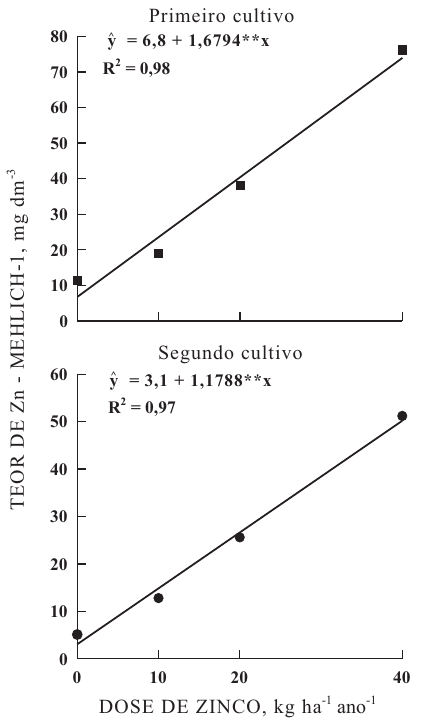
Figura 2. Teor de Zn no solo extraído por Mehlich-1 em função de doses de zinco, via solo, em dois cultivos. (**significativo a 1 % pelo teste de